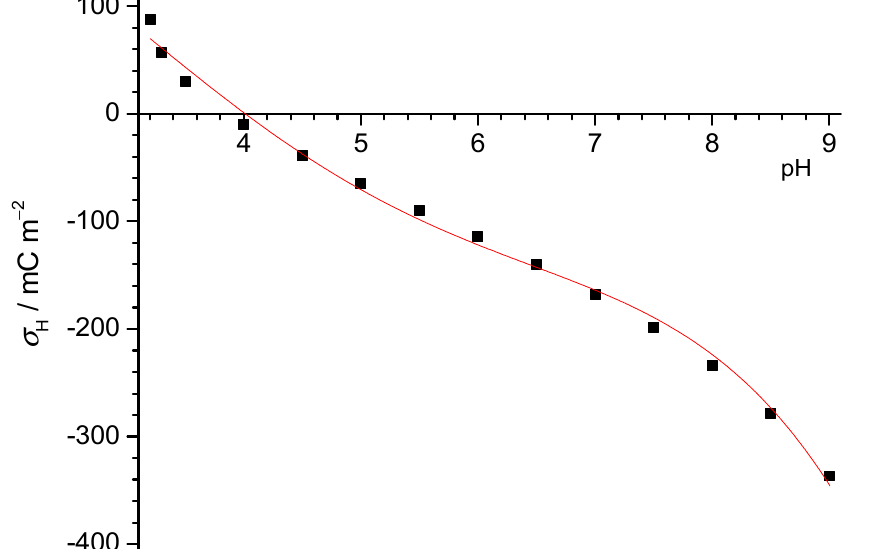
Figure 2. Surface charge of carbon nanotube (CNT) obtained by potentiometric acid–base titrations in sodium chloride aqueous solution. Lines represent third order polynomial fit used to determine pH pzc . I c = 2 mmol dm − 3 , θ = 25 °C.